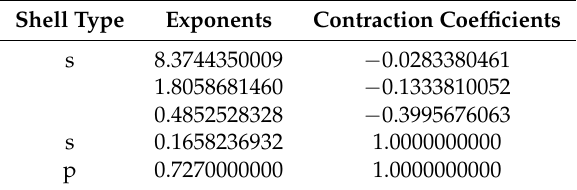
Table A4. Parameters of the cc-DZVP basis set of Hydrogen. Parameters taken from [80].